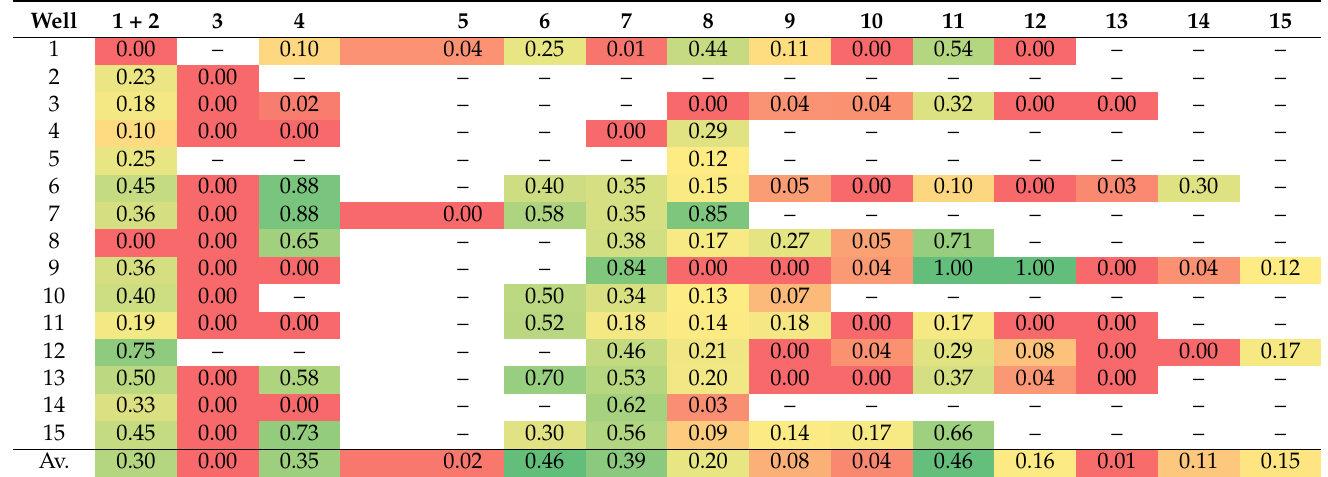
Table 2. Sandstone fraction for all analyzed units for the 15 selected wells. Unit index as indicated in Figure 2a, well locations in Figure 2b. Color-coding from red = low, over yellow = medium to red = high. Av. =